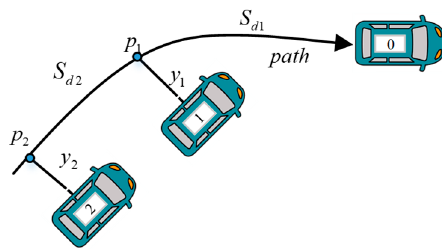
Figure 1. Platoon path following strategy. Vehicle 0 denotes the leading vehicle. Other vehicles denote the following vehicles in platoon.